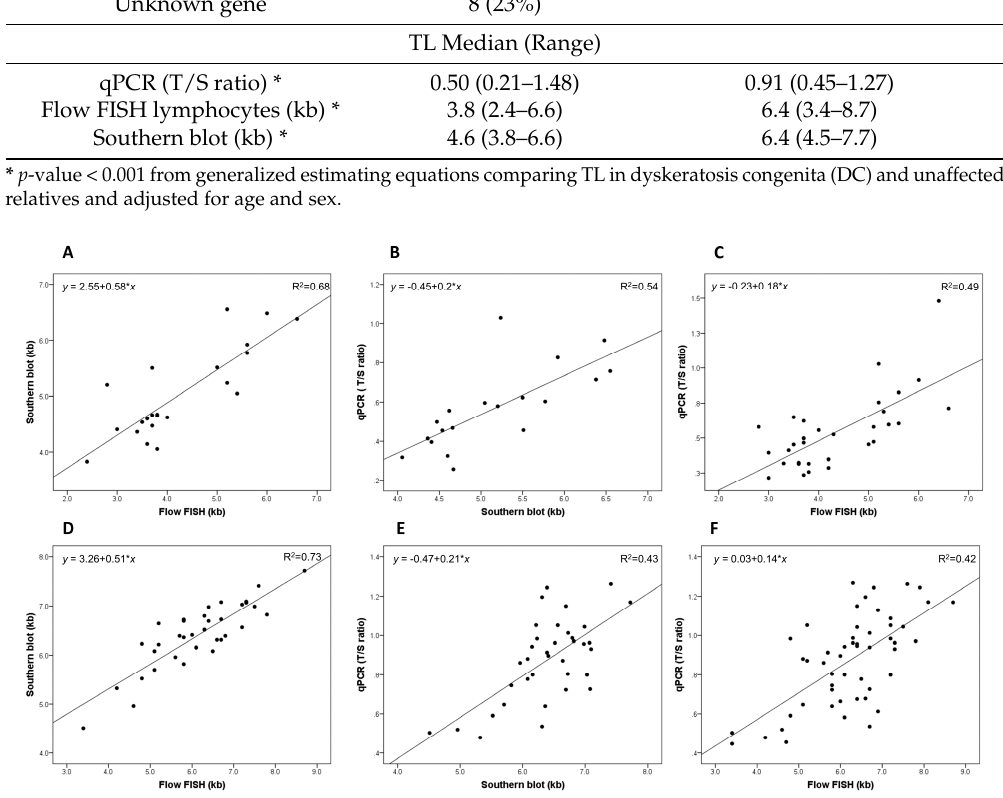
Figure 1. Correlation of telomere length measurements (TLMs) between quantitative polymerase chain reaction (qPCR), total lymphocytes by flow cytometry with fluorescence in situ hybridization (flow FISH) and Southern blot in patients with dyskeratosis congenita (DC) and in their unaffected relatives; kb: kilobases. ( A ) Correlation between flow FISH and Southern blot in patients with DC; ( B ) Correlation between qPCR and Southern blot in patients with DC; ( C ) Correlation between qPCR and flow FISH in patients with DC; ( D ) Correlation between flow FISH and Southern blot in unaffected relatives; ( E ) Correlation between qPCR and Southern blot in unaffected relatives and ( F ) Correlation between qPCR and flow FISH in unaffected relatives.